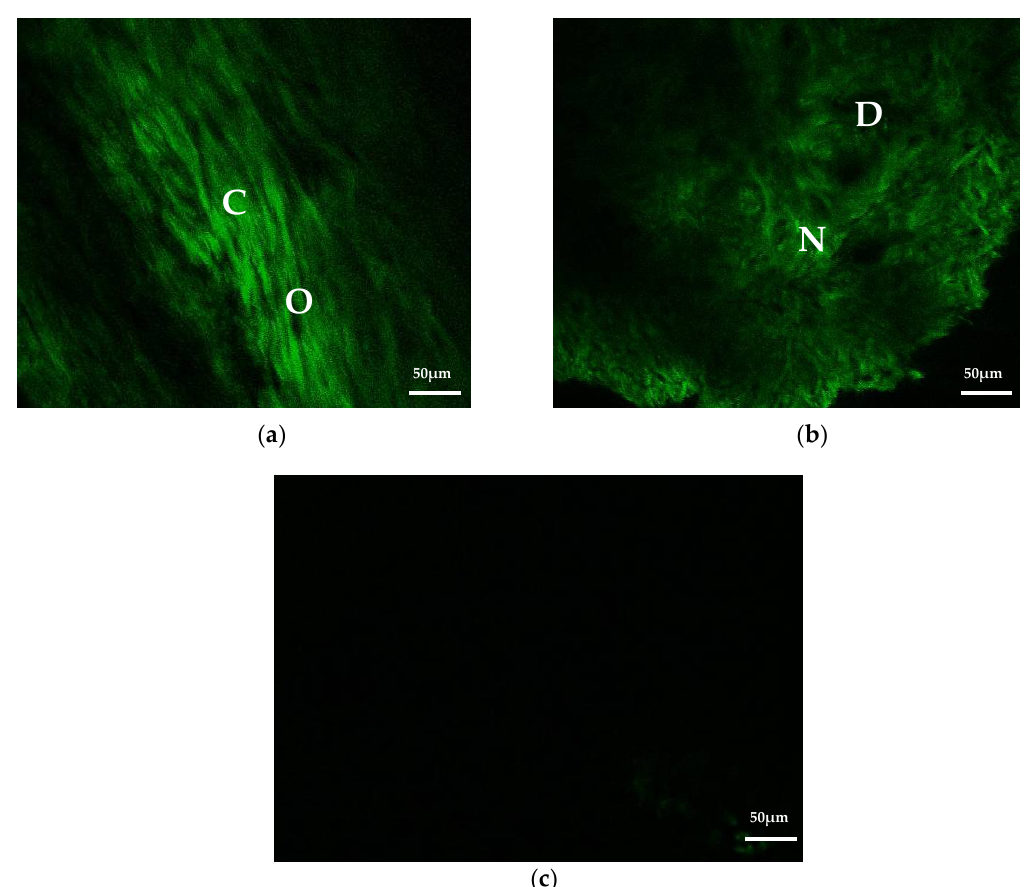
Figure 8. Second harmonic generation imaging. ( a ) Image of normal rat femur bone tissue. Well-aligned type I collagen fibers (C) are shown as green woven fibers, whereas the locations of osteocytes (O) can be observed at dark spindle-shaped areas. ( b ) The image of the drill hole that was filled with the Gel/HA–HAP composite for 1 month showed newly formed type I collagen fibers (N) around the composite, which evidenced new bone ingrowth near the bone defect area. Those dark areas (D) may indicate the residual HAP particles or those osteocytes that just migrated into this area. ( c ) Image of the Gel/HA–HAP composite itself before implantation shows no SHG signal at all.